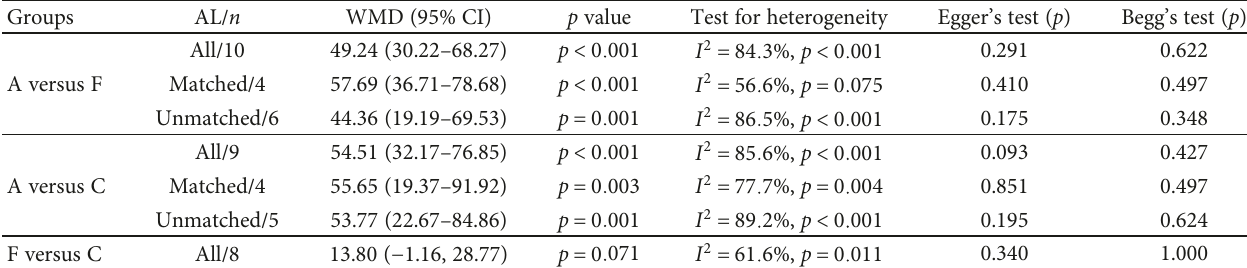
Table 2: Pooled results comparing SFCT in the amblyopic eye with the fellow eye and the normal control eye.